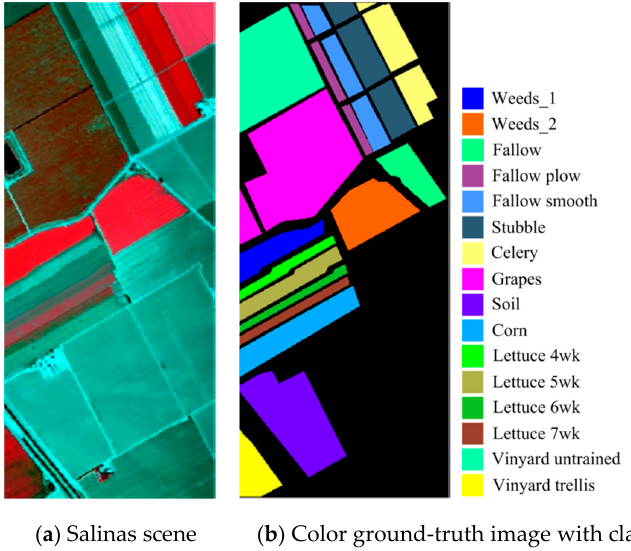
Figure A3. Ground-truth of Salinas scene with 16 classes